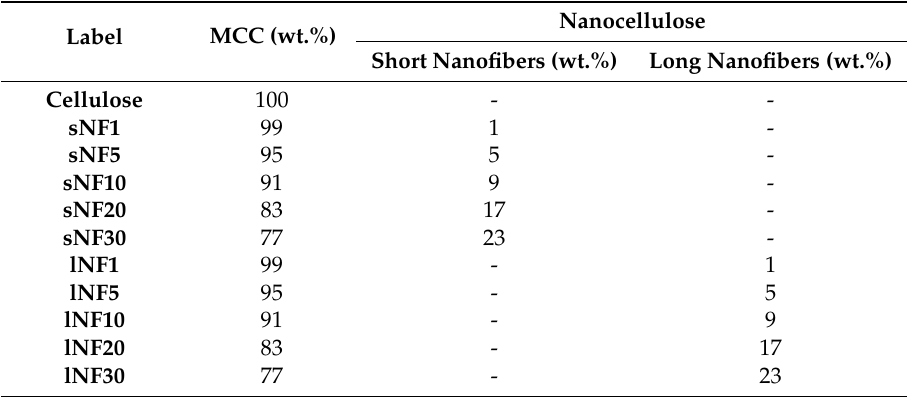
Table 1. Label and final formulation of the samples. Nanocellulose Label MCC (wt.%) Short Nanofibers (wt.%) Long Nanofibers